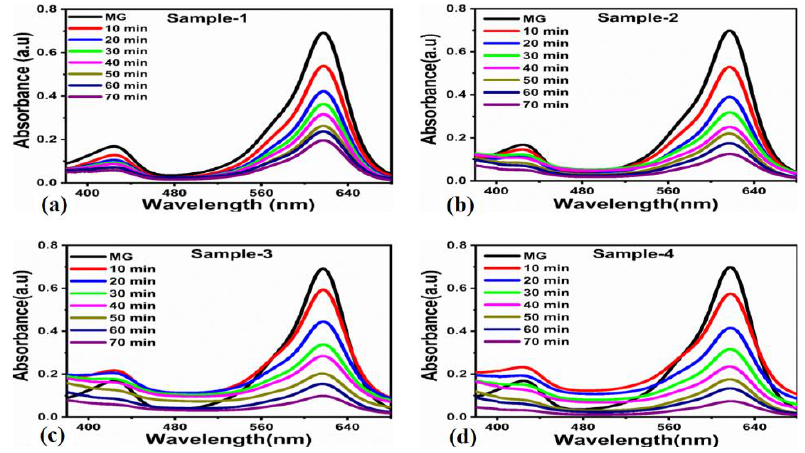
Figure 11. ( a – d ) change in the UV-Vis spectrum of the MG solution at concentration of 5.48 × 10 −5 M during photodegradation under UV light irradiation, using 5 mg dose of samples 1 – 4 as photocatalysts.